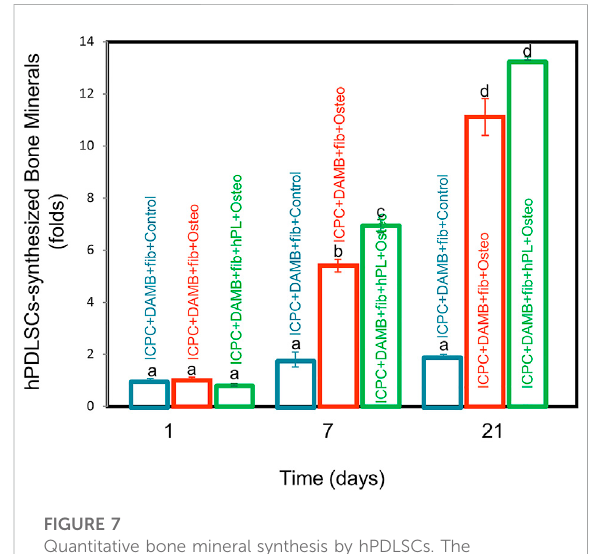
FIGURE 7 Quantitative bone mineral synthesis by hPDLSCs. The hPDLSC-synthesized bone mineral in ICPC + DAMB + fi brin + hPL + osteo group and ICPC + DAMB + fi brin + FBS + osteo group was 13.2foldsand11.1foldsthatofthecontrolgroup,respectively (mean ± sd; n = 6). Values with dissimilar letters are signi fi cantly different from each other ( p < 0.05).